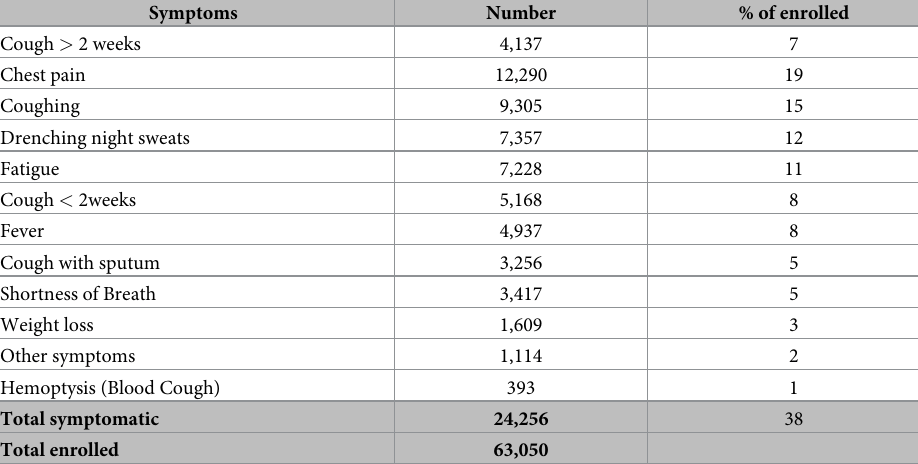
Table 1. Frequency of TB related symptoms among survey